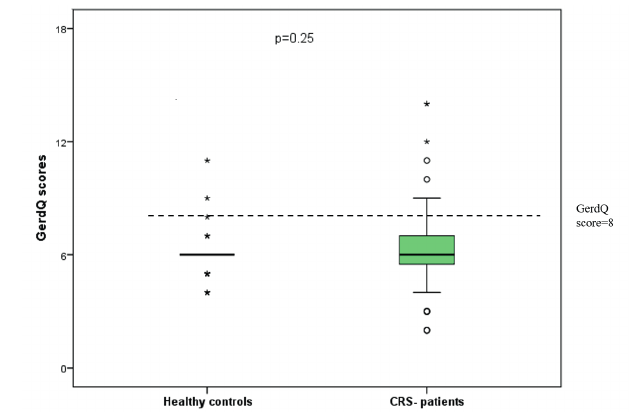
Figure 1. GerdQ scores in healthy controls and